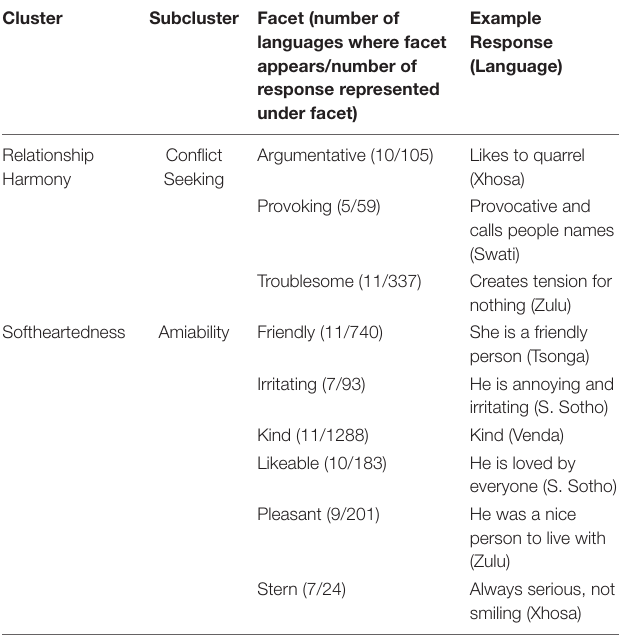
TABLE 1 | Clusters, subclusters, facets of personality-descriptive terms, and example responses. Cluster Subcluster Facet (number of languages where